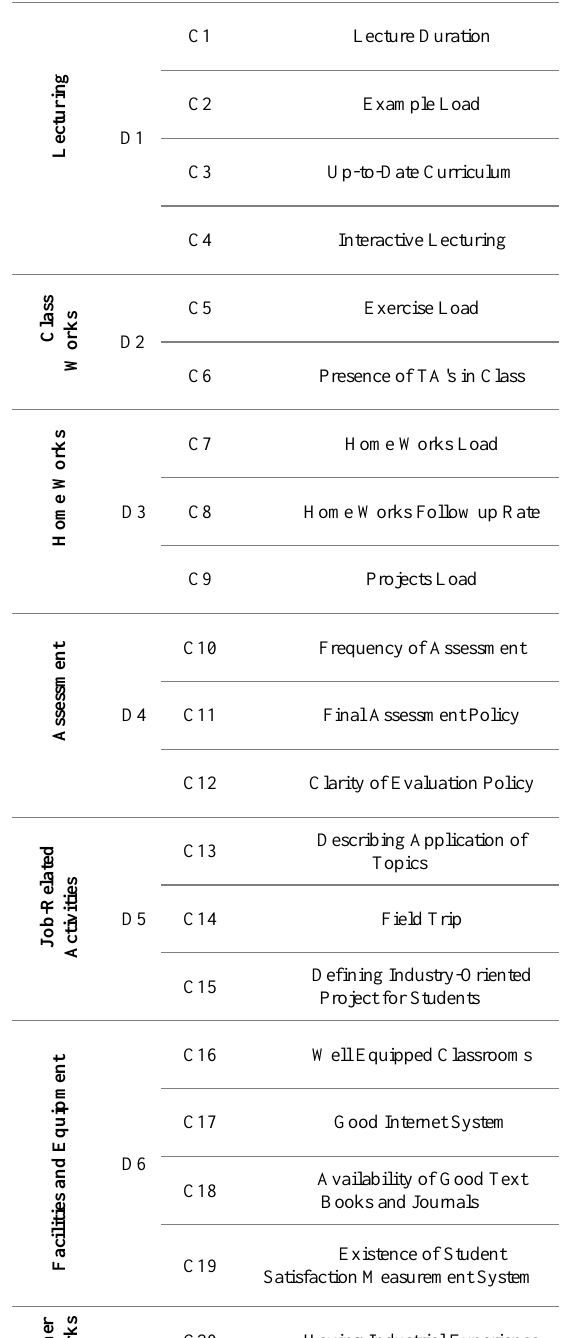
Table 2. Dimensions and criteria affecting the efficiency of teaching engineering